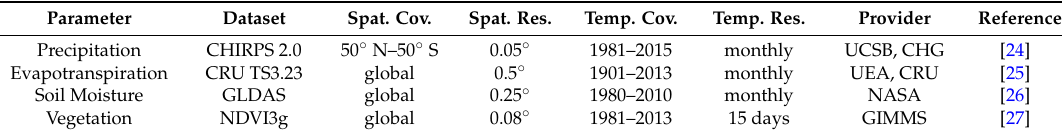
Table 1. Datasets used to calculate the drought